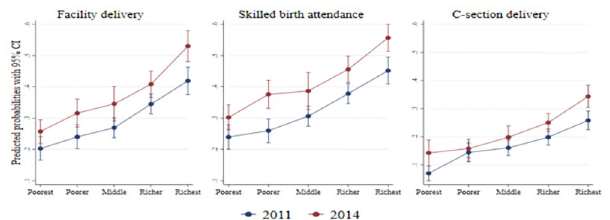
Fig 2. Predicted probabilities of delivery care service utilisation across wealth quintile.